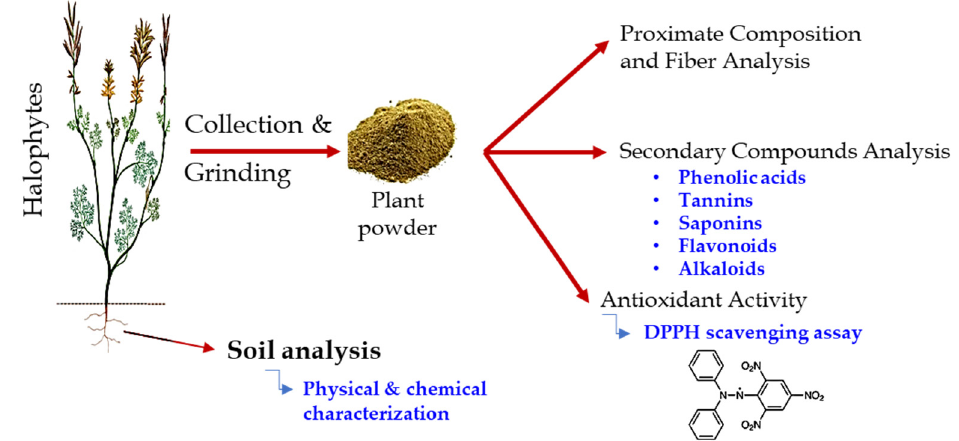
Figure 3. A schematic diagram of the methodological approach.